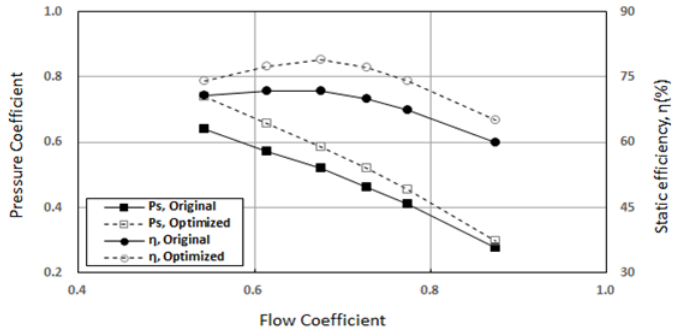
Figure 11. Comparison of performances between the original and optimized models (at 1100